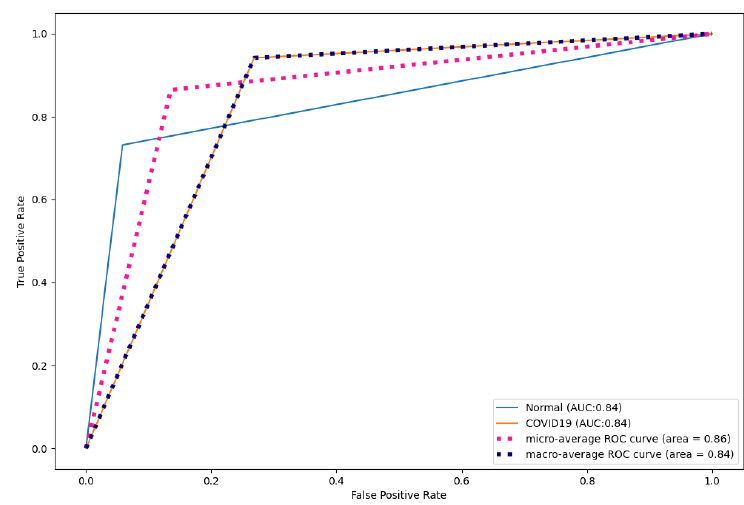
Figure 10. DesNet121 ROC curves for CT images.